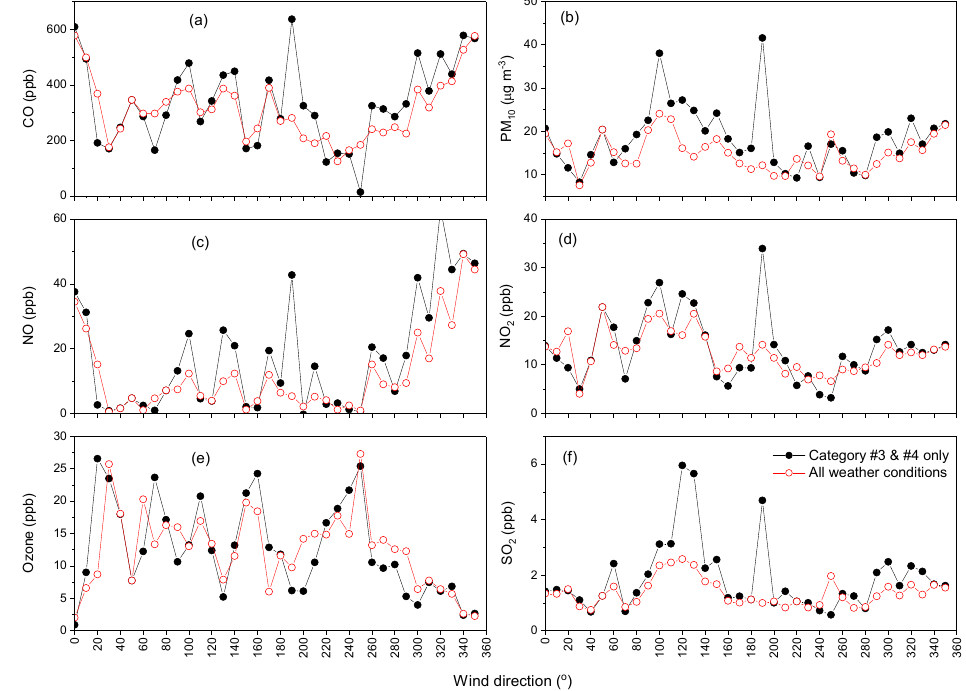
Figure 19. Angular distributions of (a) CO, (b) PM 10 , (c) NO, (d) NO 2 , (e) O 3 and (f) SO 2 at Westmead during SPS-II for all weather conditions (red) and category #3 & #4 days only (black).